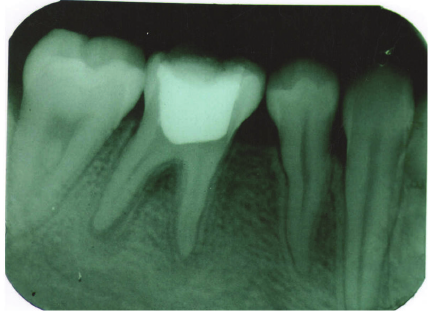
Figure 3: Healing at 9 months